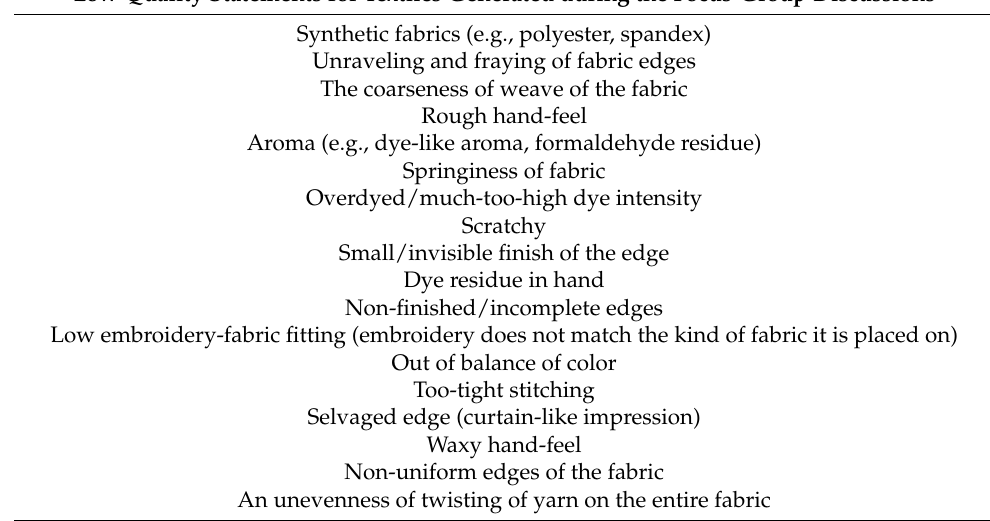
Table 3. A list of 40 low-quality statements for textiles that were generated from the focus groups. Low-Quality Statements for Textiles Generated during the Focus-Group